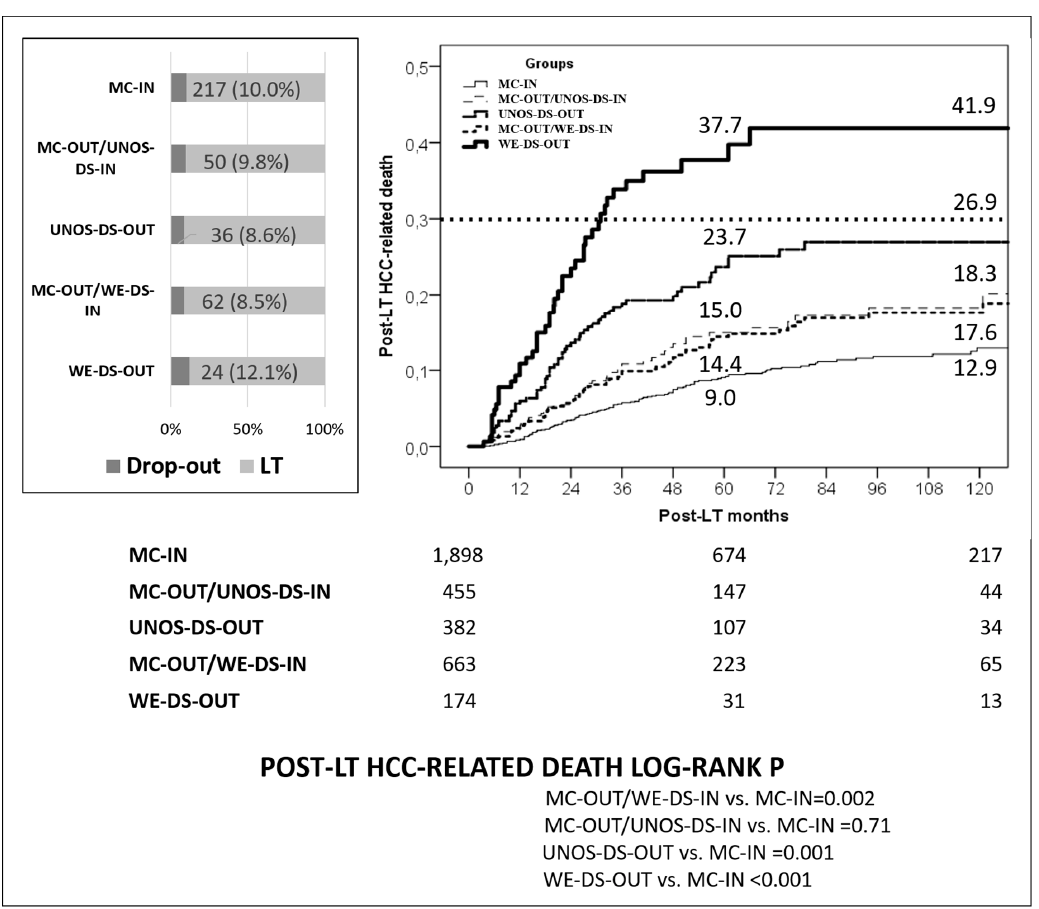
Figure 4. Dropout and post-LT HCC-related death rates in the MC-IN, MC-OUT/UNOS-DS-IN, UNOS-DS-OUT, MC-OUT/WE-DS-IN, and WE-DS-OUT patients. Dashed line identifies the post-LT 5-year 30% of HCC-related death proposed by Mazzaferro [18].